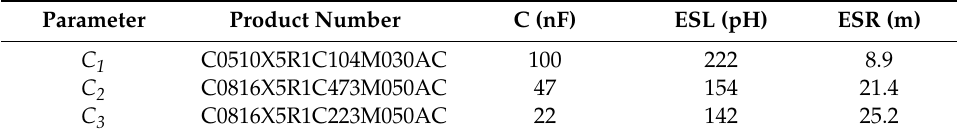
Table 1. Electrical properties of the three TDK Multilayer Ceramic Chip decoupling capacitors (C 1 , C 2 , C 3 ).